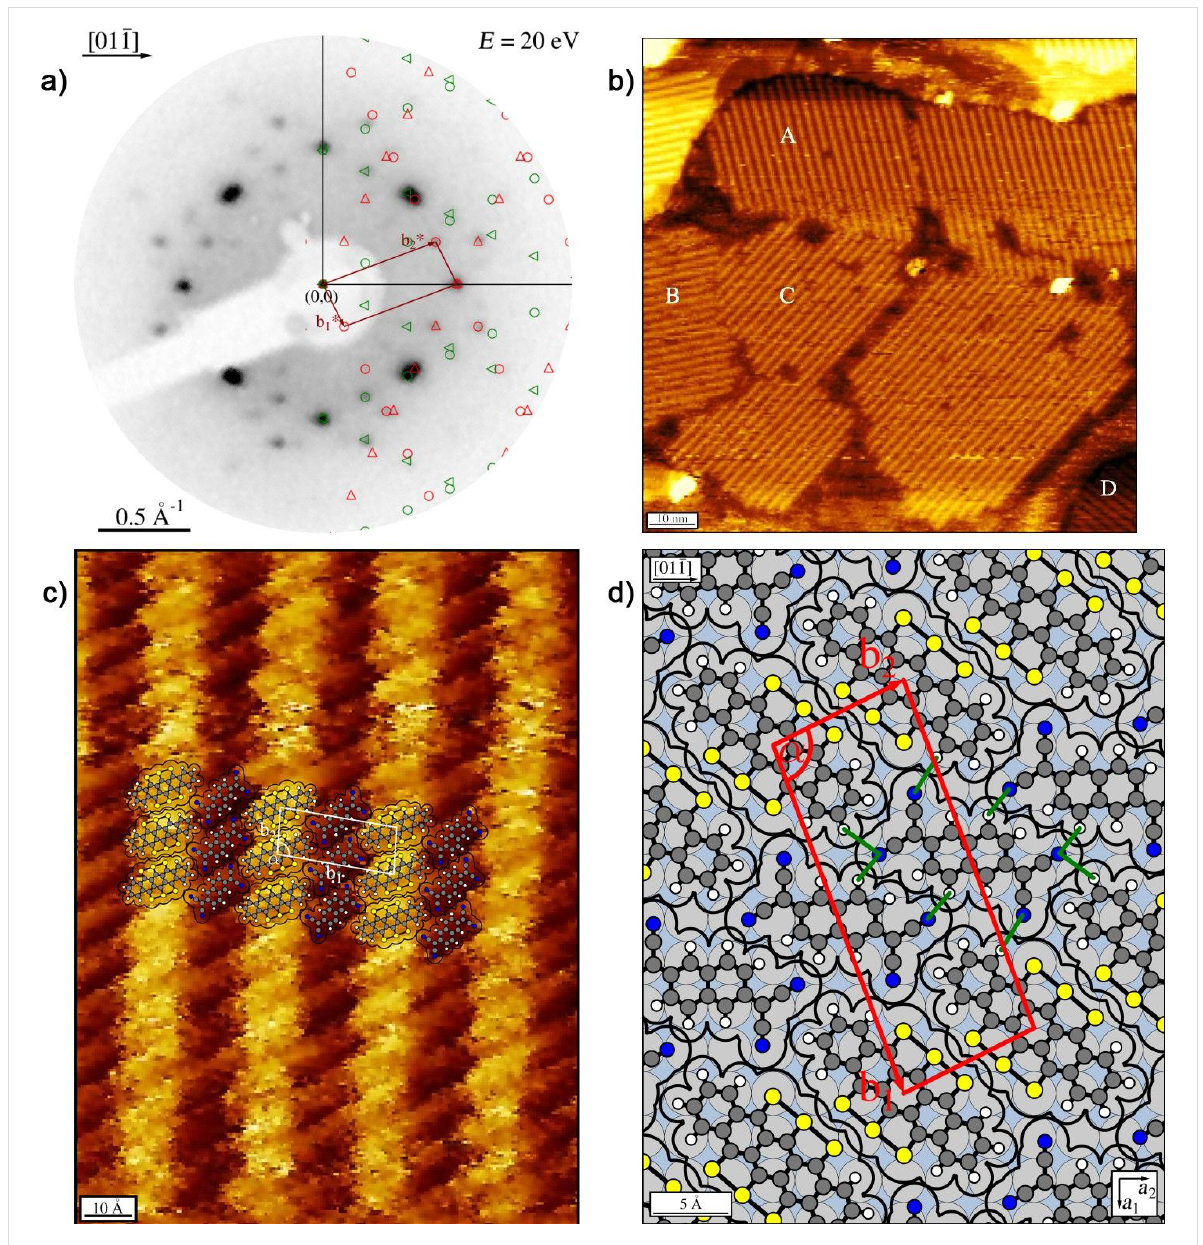
Figure 6: Mixed structure formed by HTPEN and TNAP on Ag(100). (a) LEED pattern recorded at an electron energy of 20 eV. A simulated diffrac- tion pattern is overlaid. Symmetry-equivalent domains are marked as in Figure 2. (b) STM image showing different islands. Here, all four possible domains with different orientations can be observed at the same time. They are marked by A–D. The fast scanning direction is in horizontal orienta- tion ( U b = − 1.51 V; I t = 82 pA). This STM image has been selected to demonstrate the presence of the different symmetry-equivalent domains. The corresonding islands are smaller than usual. (c) STM image. The fast scanning direction is horizontal ( U b = − 0.80 V; I t = 80 pA). A hard-sphere model of the structure derived from LEED has been superimposed. (d) Hard-sphere model with indicated unit cell and suspected hydrogen bonds (green lines) to nitrogen atoms of the